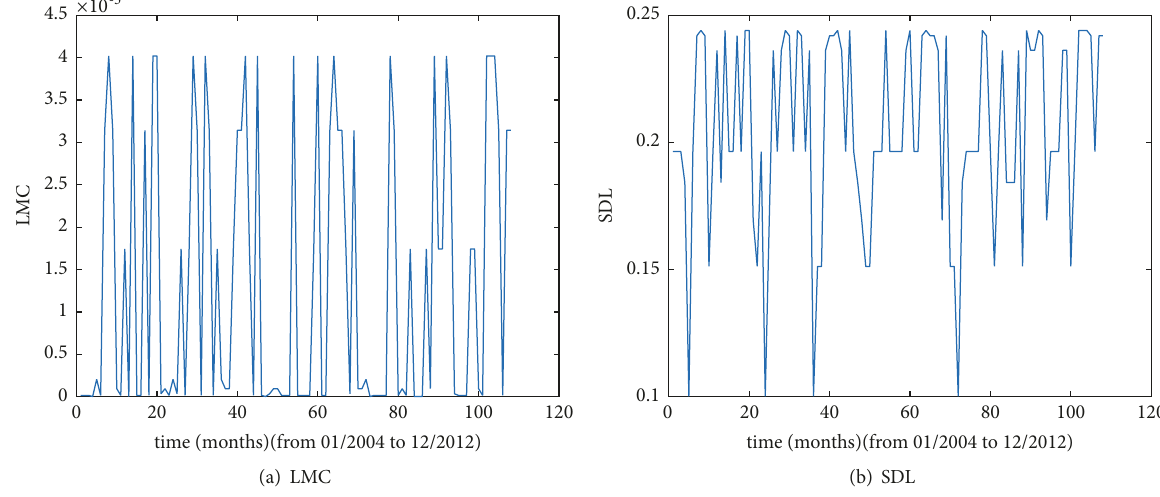
Figure 3: Temporal evolution of complexity (16-part division).